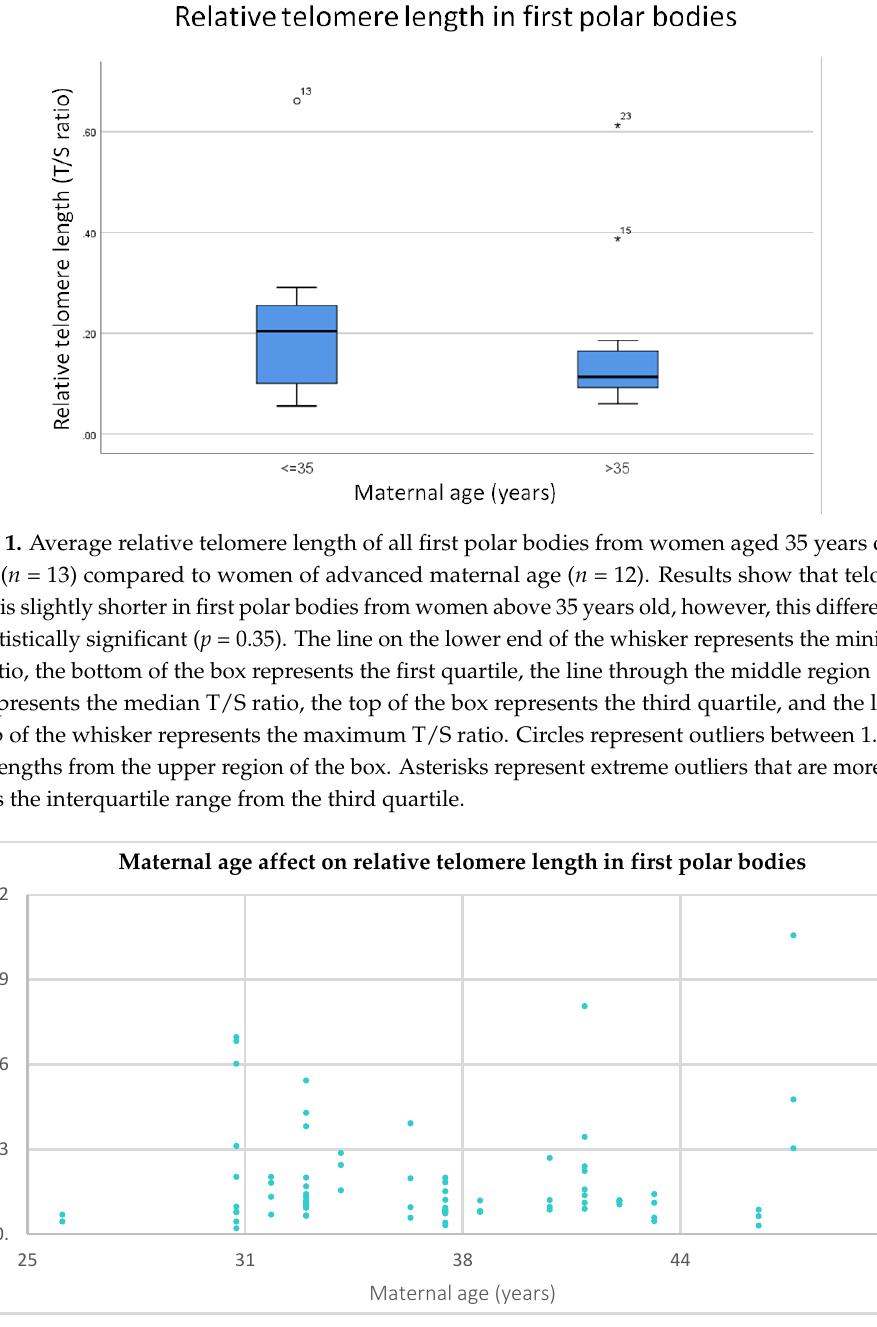
Figure 2. Relative telomere lengths of aneuploid and euploid first polar bodies in relation to maternal age ( n = 82 first polar bodies from n = 25 women). Results indicate no correlation between relative telomere length of first polar bodies and maternal age ( p = 0.52).